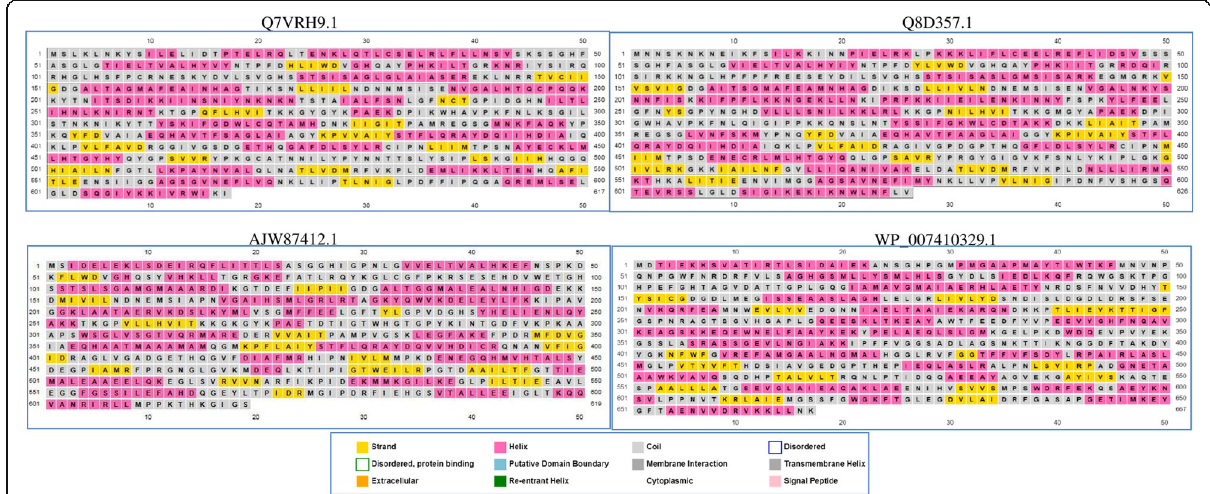
Fig. 5 PSIPRED based estimation of the secondary structure for the representative sequences ( a ) Q7VRH9.1, ( b ) Q8D357.1, ( c ) AJW87412.1, and ( d ) WP_007410329.1 of the two sets A and B